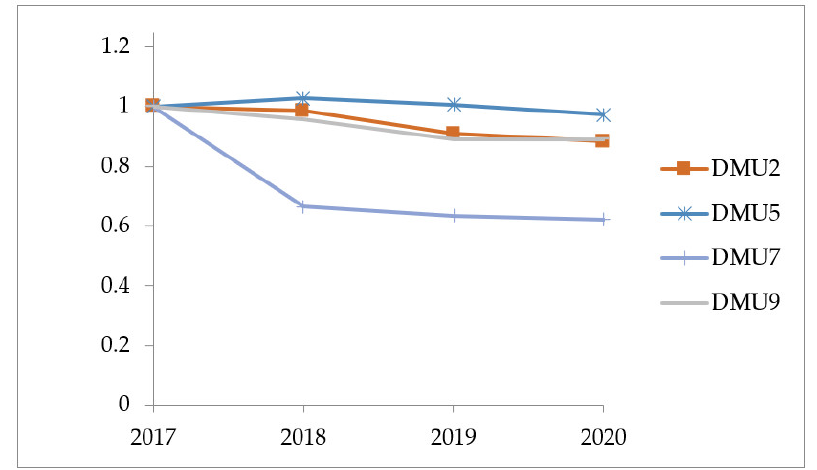
Figure 7. Cumulative frontier-shift (CFS) .